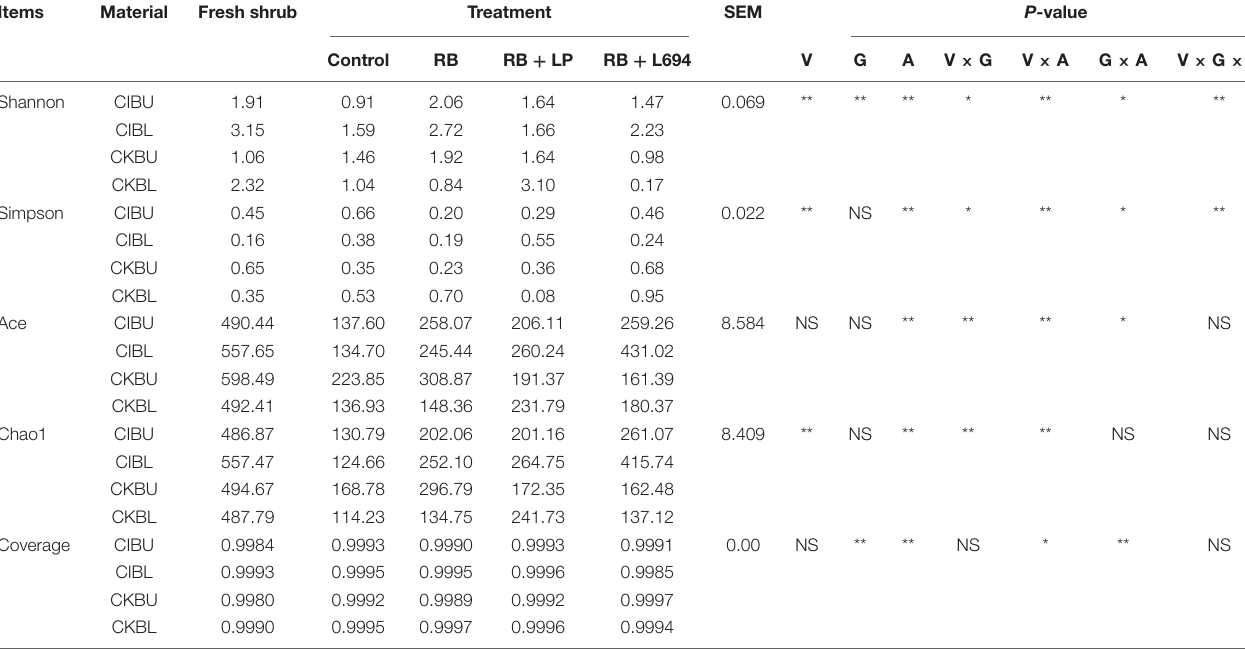
TABLE 3 | Analysis of alpha diversity of Caragana silage after ensiling ( n = 3). Items Material Fresh shrub Treatment SEM P